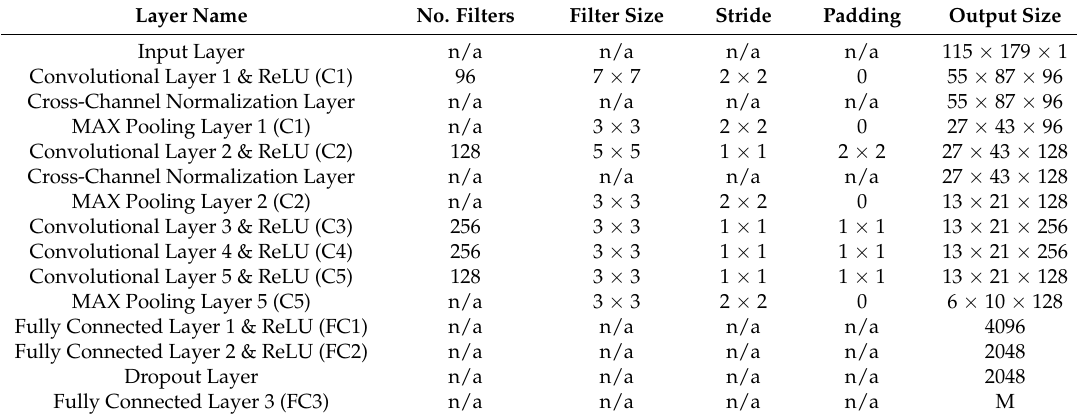
Table 2. Detailed structure description of our proposed CNN method for the person